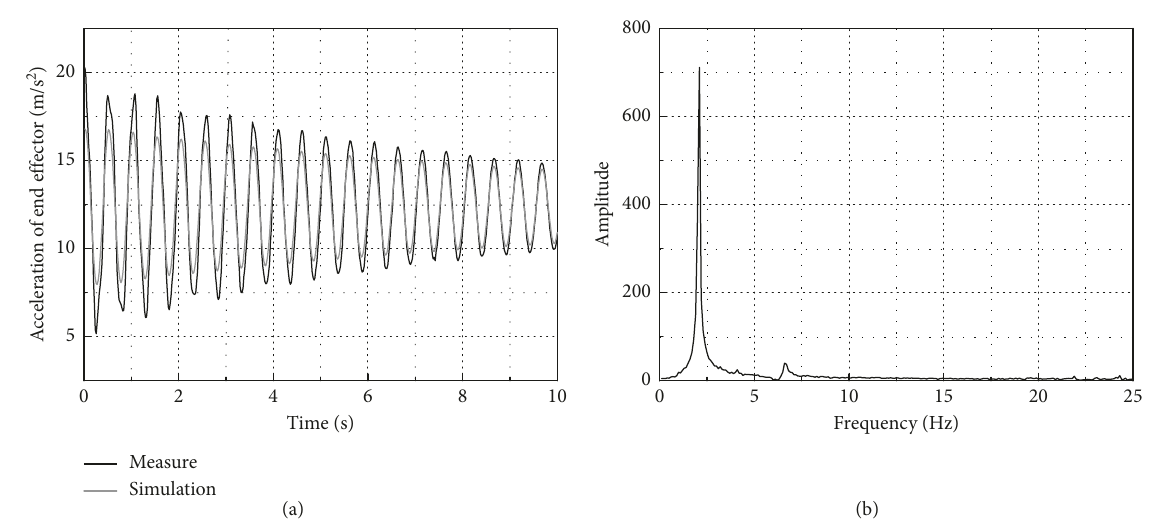
Figure 10: (a) Acceleration of flexible link’s tip. (b) The spectrum of the flexible link’s tip acceleration.